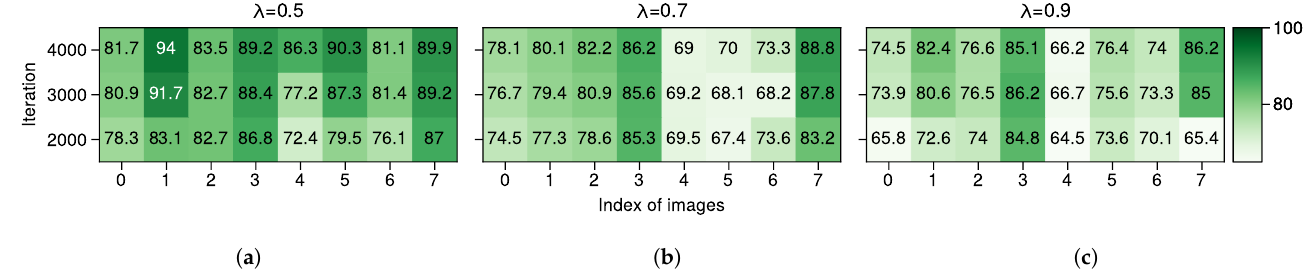
Figure 10. P ch : Percentage (%) of correct high-quality pseudo-labels with different threshold λ on POT → VAI, calculated from the same images in Figure 8. ( a ) λ = 0.5. ( b ) λ = 0.7. ( c ) λ =